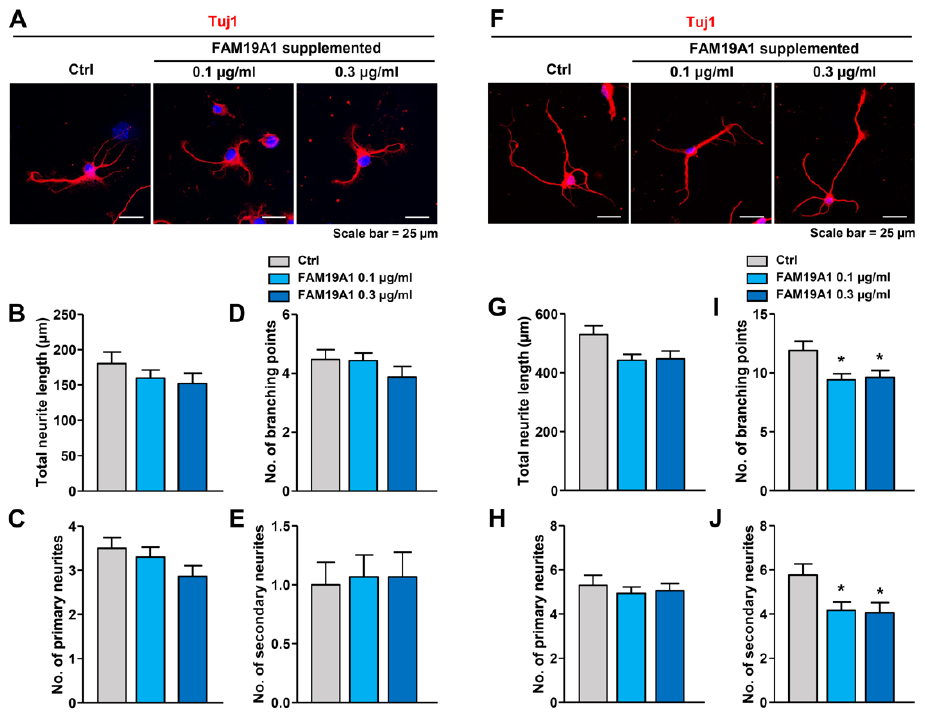
Figure 6. Neuronal morphology of his-tagged FAM19A1-treated wild-type (WT) primary hippocampal neurons. ( A – E ) Primary hippocampal neurons at days in vitro 3 (DIV 3). ( A ) Representative images of non-treated (Ctrl) and his-tagged FAM19A1-treated WT primary hippocampal neurons at DIV 3. Neuronal morphologies were analyzed in terms of total neurite length; ( B ), total number of primary neurites; ( C ), total number of branching points; ( D ), and total number of secondary neurites; ( E ). ( F – J ) Primary hippocampal neurons at days in vitro 6 (DIV 6). ( F ) Representative images of non- treated (Ctrl) and his-tagged FAM19A1-treated WT primary hippocampal neurons at DIV 6. Neuronal morphologies were analyzed in terms of total neurite length; ( G ), total number of primary neurites; ( H ), total number of branching points; ( I ), and total number of secondary neurites; ( J ). Experiments were performed in triplicate and at least 30 neurons were ana- lyzed for each experimental group. Data are presented as means ± standard errors of means (SEM). * p < 0.05 versus non- treated by one-way analysis of variance (ANOVA) with Bonferroni post-hoc test.